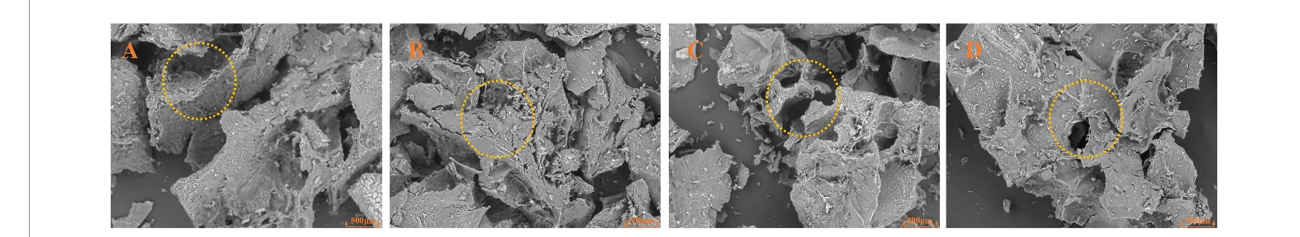
FIGURE3 Scanning electron microscopy images (200x) of dietary fiber from different bamboo shoots. A-BSDF (A) , B-BSDF (B) , C-BSDF (C) , D-BSDF (D) .